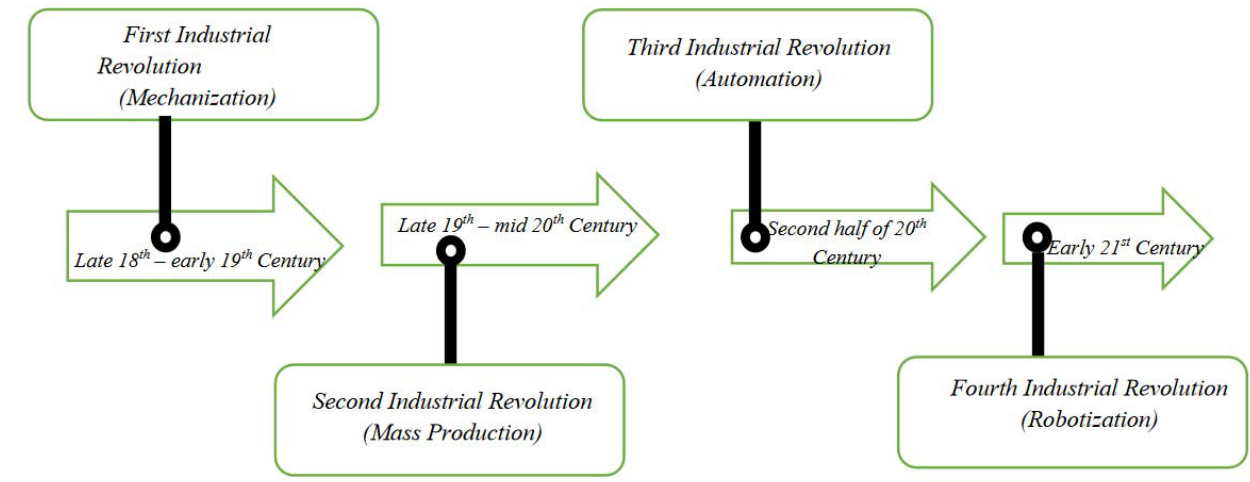
Figure 1. The four industrial